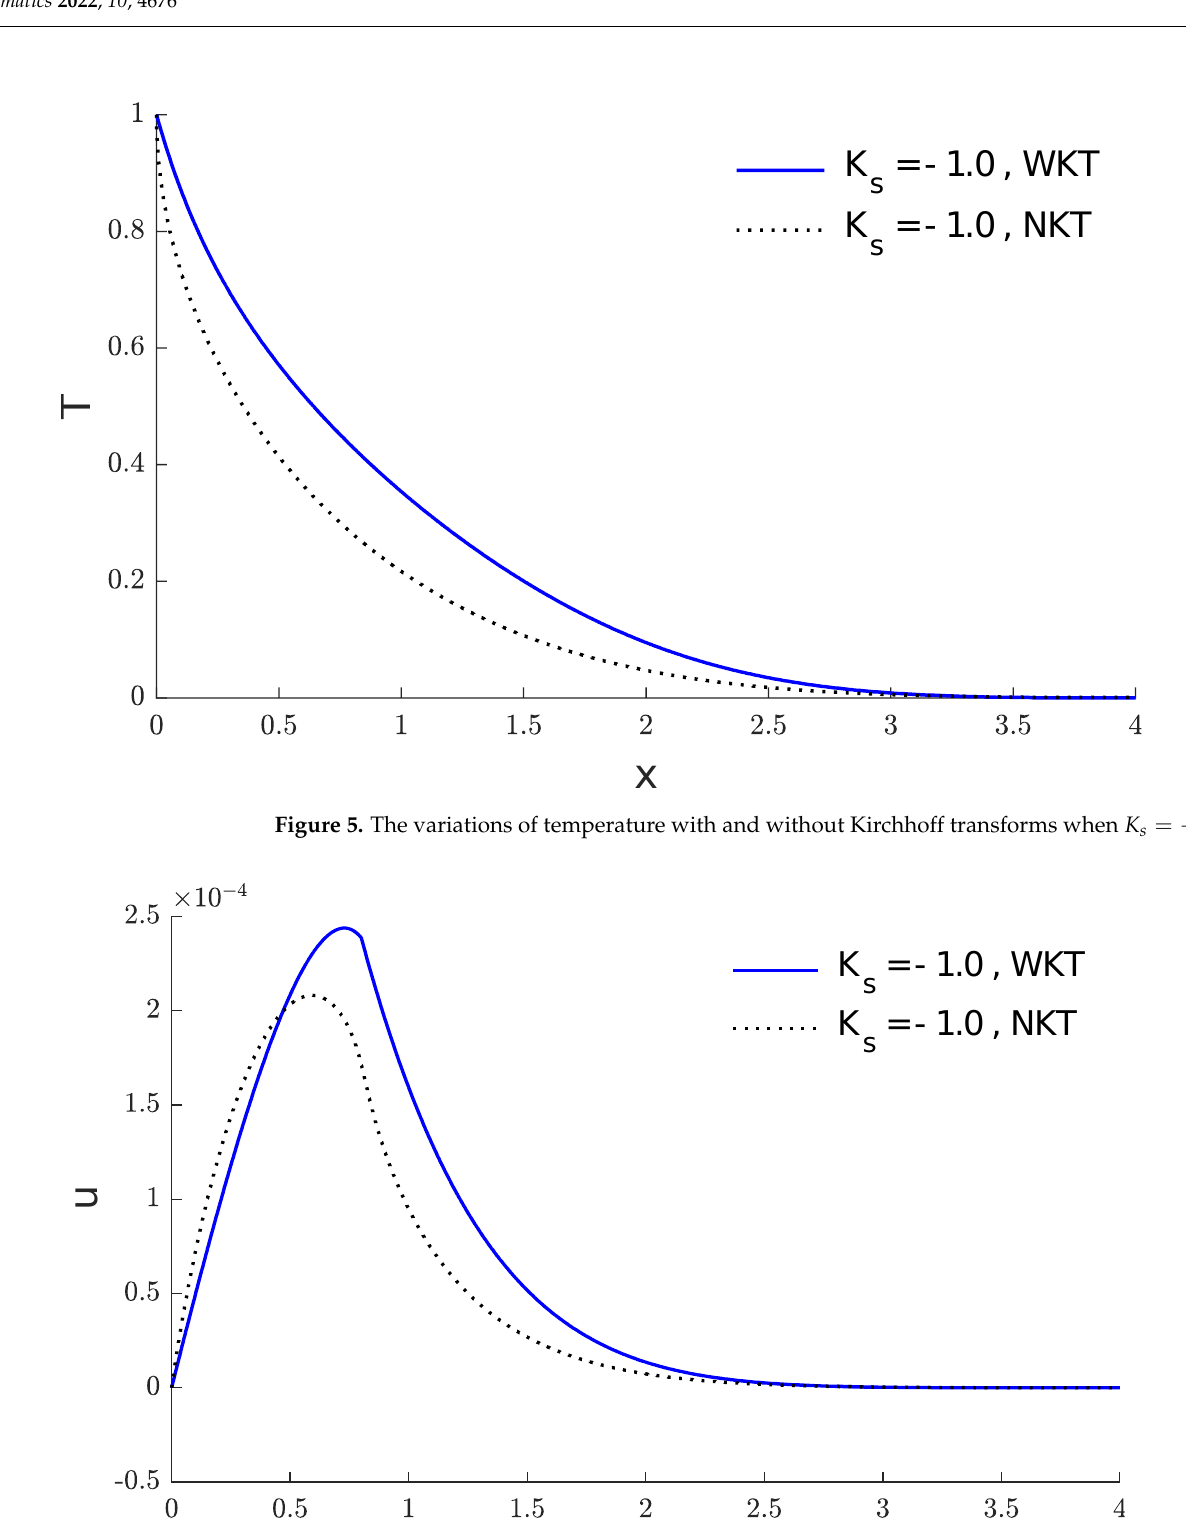
Figure 6. The variations of displacement with and without Kirchhoff transforms when 𝐾 𝑠 = −1 .